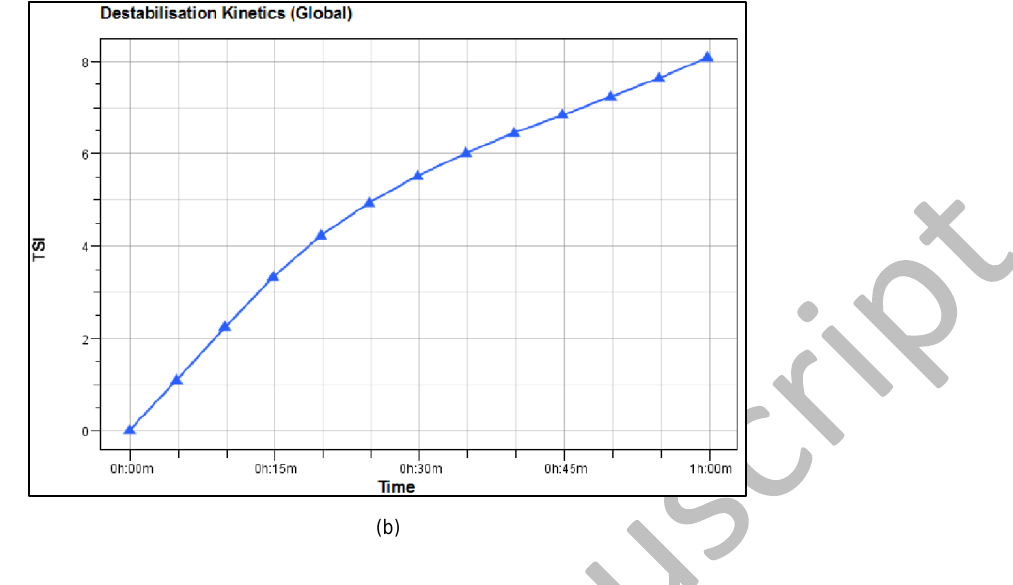
Fig. 10–Comparison of Turbiscan analysis of sample without demulsifier DB (a) and after the addition of demulsifier DB dosage at 7ppm (b) conducted at 60